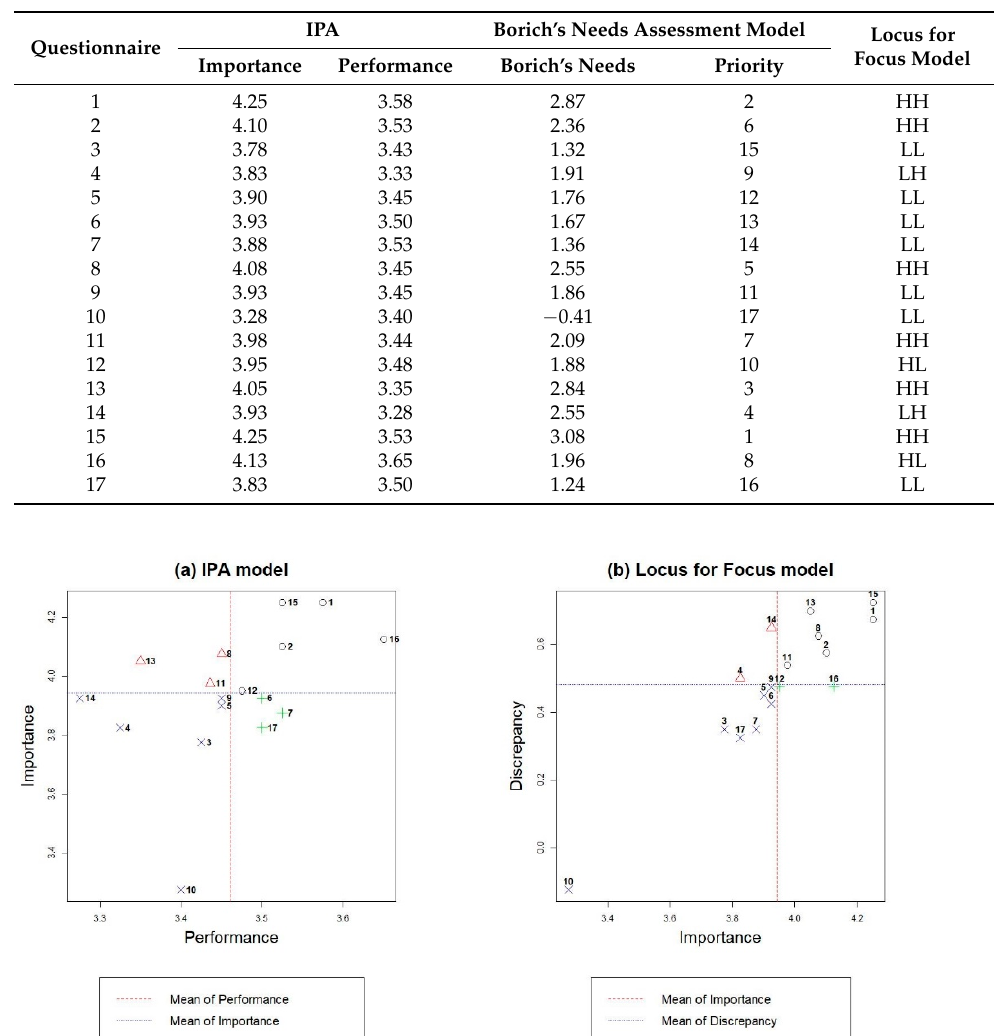
Table 5. IPA, Borich’s needs assessment, and the locus for focus model for Costa Concordia Case 2 (from the IMO long-term action plan).